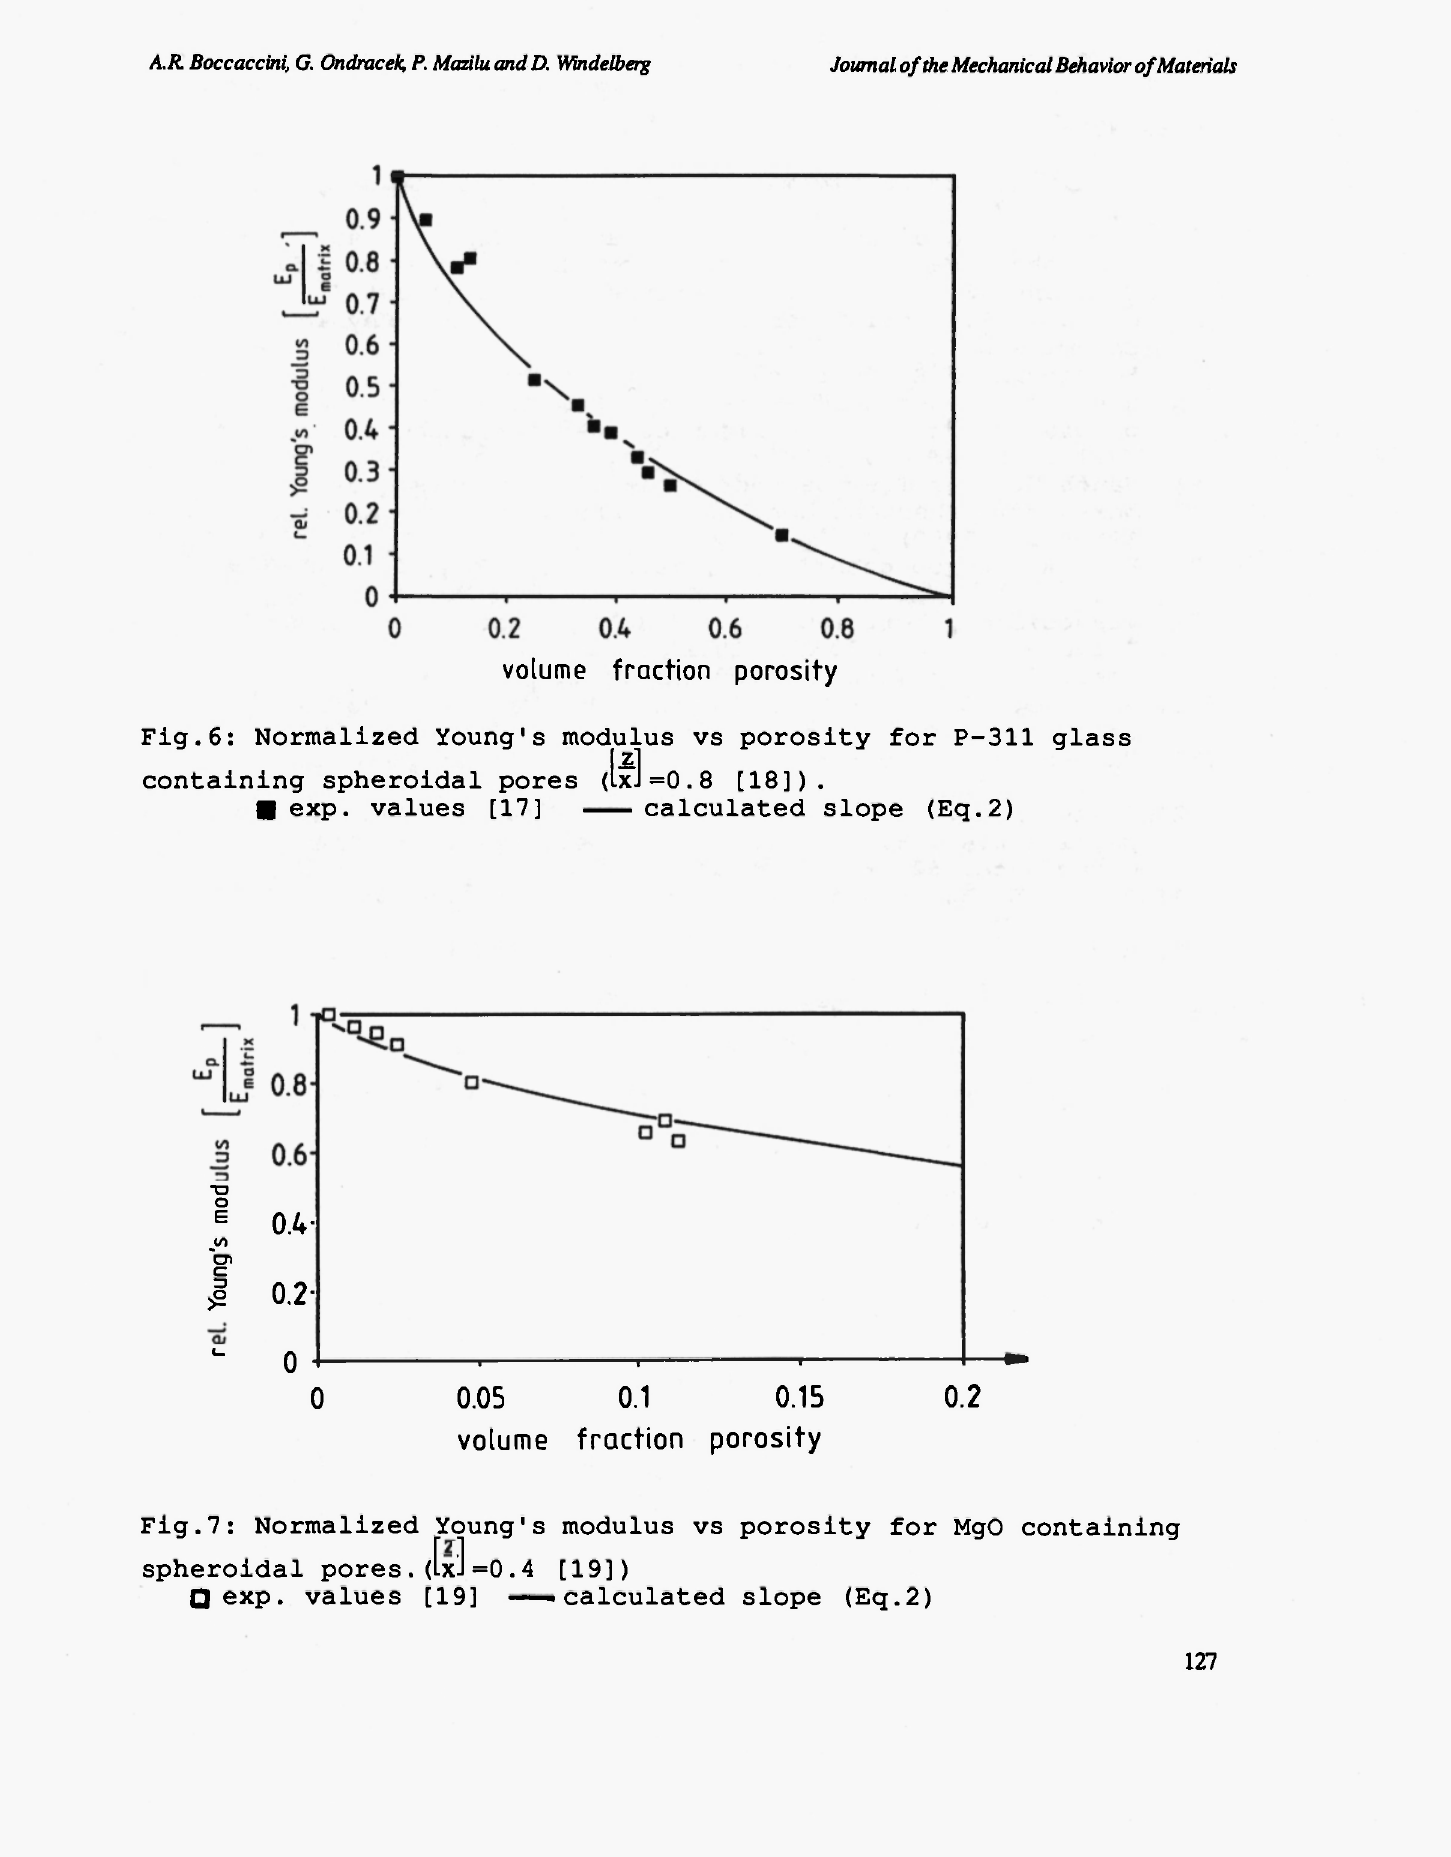
Fig.6: Normalized Young's modulus vs porosity for P-311 glass Ii] containing spheroidal pores (LxJ =0 . 8 [18]). • exp. values [17]